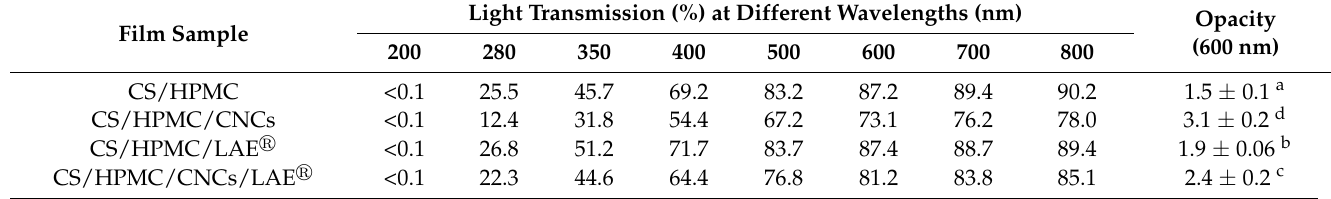
(cid:114) , 5% w / w of